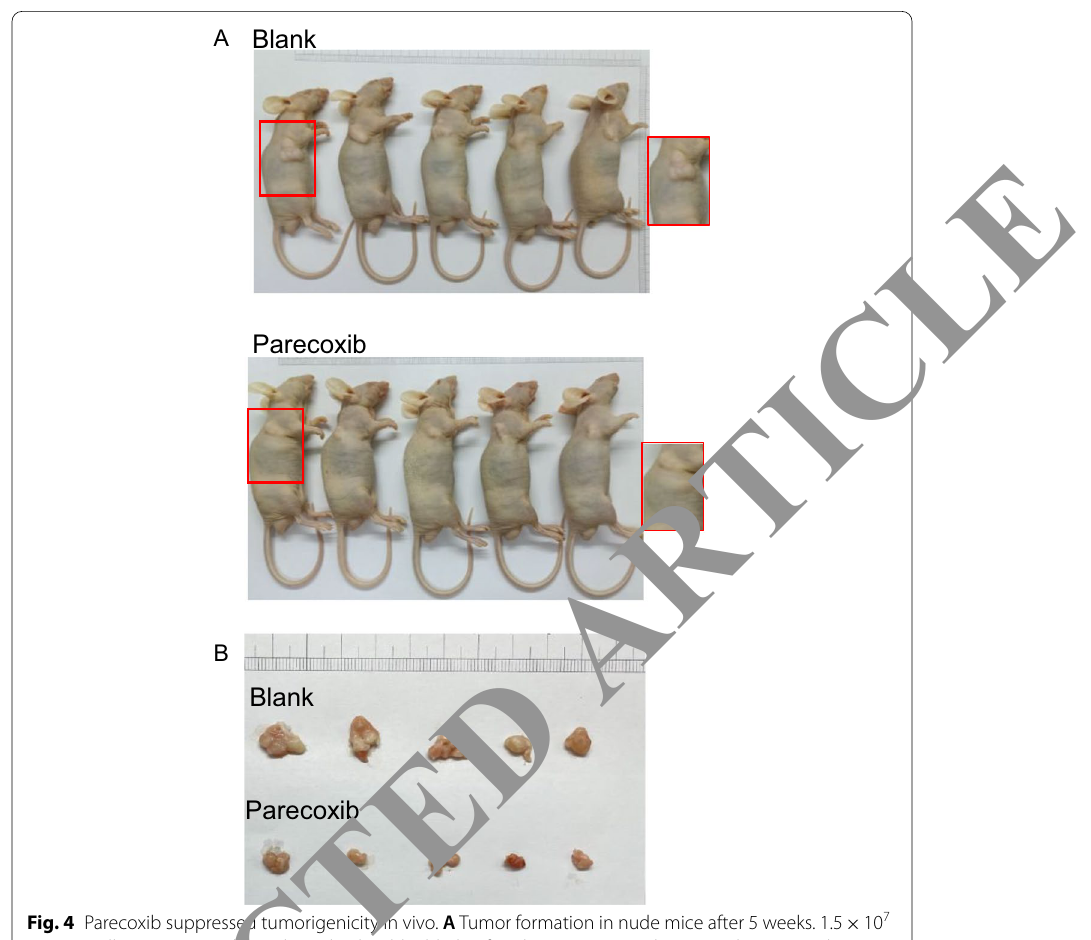
Fig. 4 Parecoxib suppressed tumorigenicity in vivo. A Tumor formation in nude mice after 5 weeks. 1.5 KYSE30 cells were injected into the right shoulder blade of nude mice. Parecoxib (0.3 mg/kg) or equal volume of normal saline (the blank group) was injected into the enterocoelia every 3 days after tumor cell inoculation. B Tumor tissues were resected from nude mice at 5 weeks